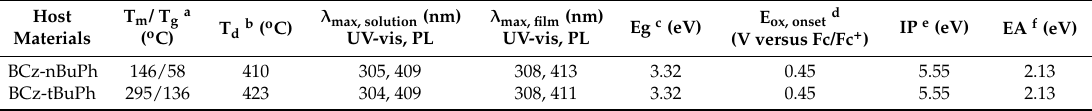
Figure 3. Cyclic voltammetry (CV) curves of BCz-nBuPh , BCz-tBuPh , and TPD in dichloromethane solution for oxidation. Table 1. The thermal, optical, and electrochemical properties of BCz-nBuPh and BCz-tBuPh